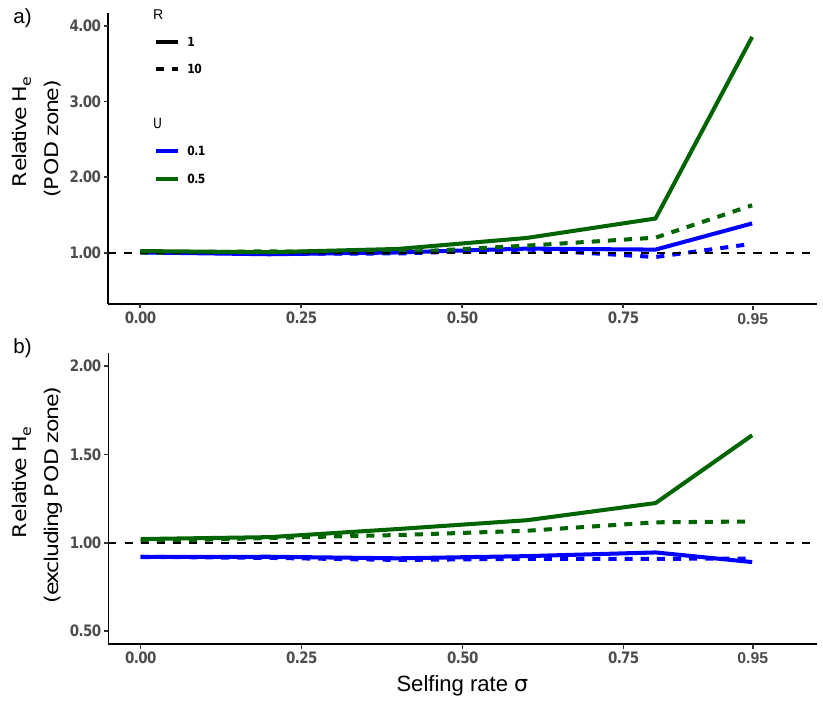
Figure 4 – Background mutations affect POD selection and vice versa. Graph (a) shows heterozygosity, H e , within the POD zone with background mutations relative to H e in the absence of background mutations and graph (b) H e elsewhere in the genome with a POD zone relative to without, both as a function of the selfing rate. Populations are subject to different background mutation rates ( U ) and shorter and longer map lengths ( R in Morgans). These simulations use 100 POD load loci ( n L = 100 ) and a map length of ℓ = 10 − 6 Morgans. Mutations within the POD zone are randomly placed. Selection coef- ficients in- and outside the POD zone ( s and s d respectively) are 0.01 with dominances h and h d = 0.2